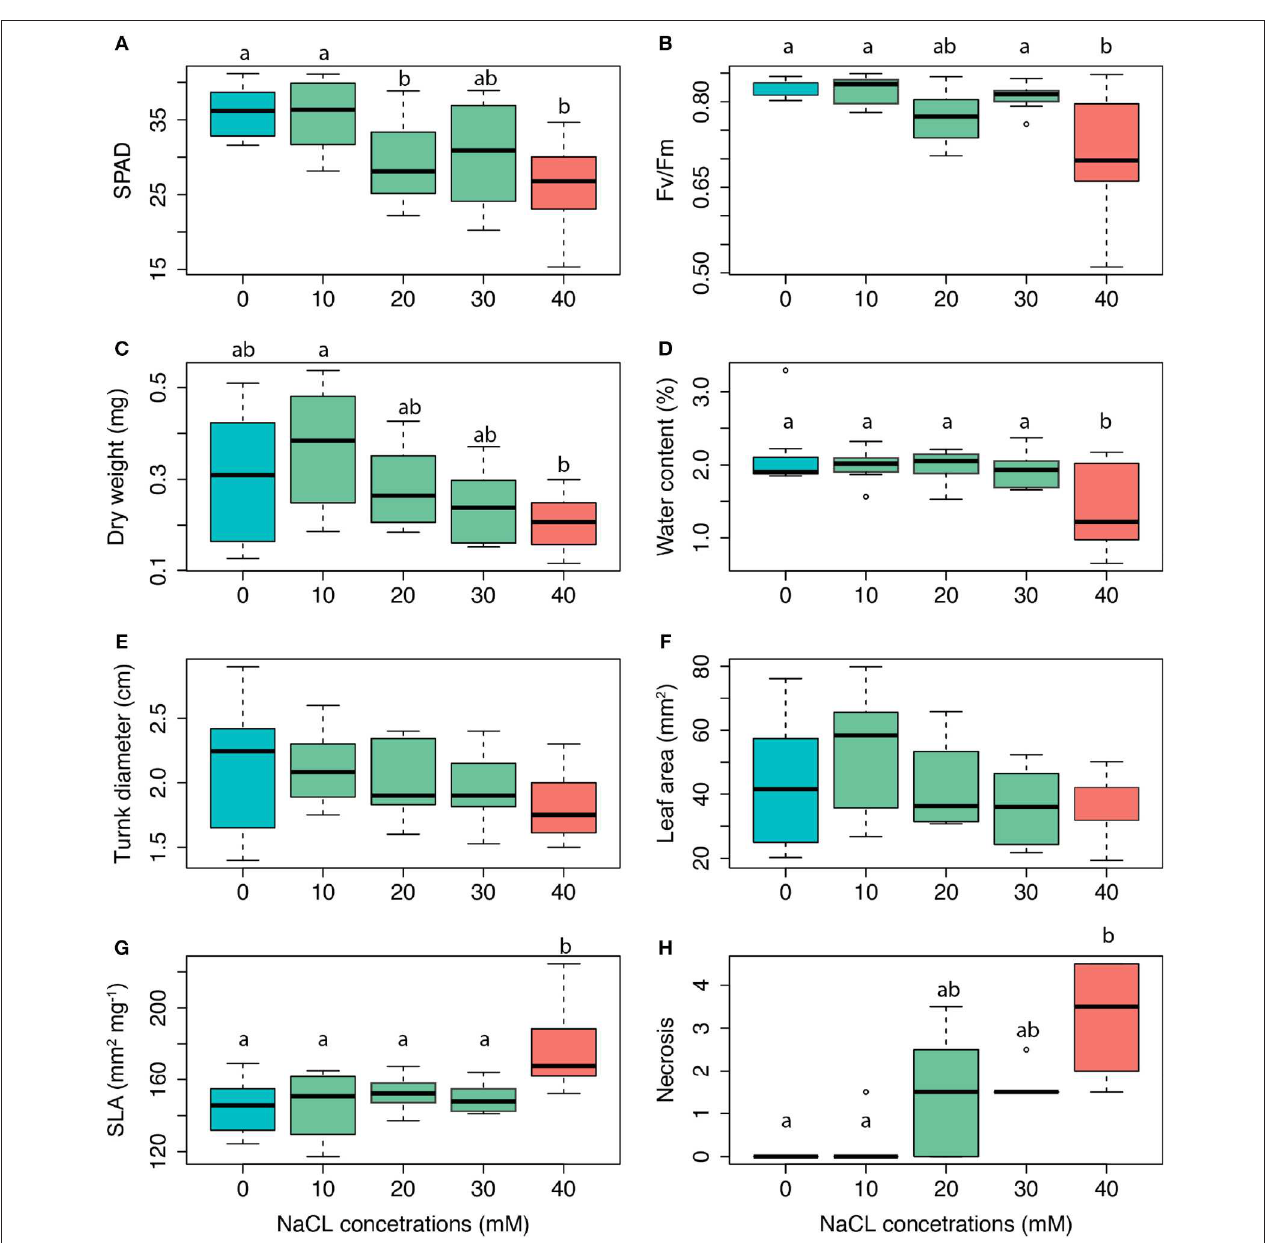
FIGURE 4 | Changes in functional traits of Tilia x vulgaris seedlings in response to four salt addition treatments (0–40mM NaCl). (A) chlorophyll content (SPAD units), (B) Fv/Fm potential maximum quantum yield of PSII, (C) DW leaf dry weight (mg), (D) WC water content (%), (E) trunk diameter at the base (cm); (F) LA leaf area (mm 2 ), (G) SLA specific leaf area (mm 2 mg − 1 ), (H) leaf injury (necrosis %). Different letters indicate significant difference among the salt treatments (Tukey’s HSD post-hoc test, p < 0.05).